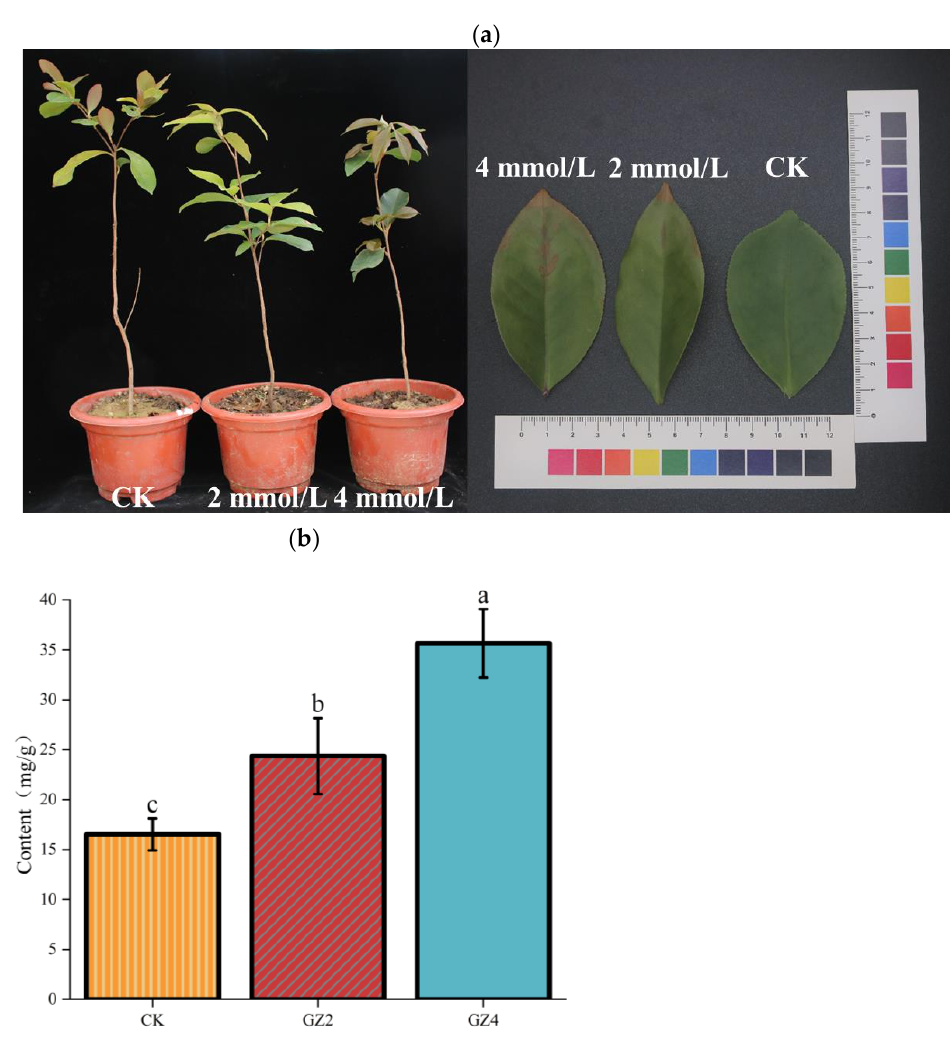
Figure 1. Responses of C. drupifera to aluminum treatment. ( a ) Morphological characteristics and ( b ) total flavonoid content under different concentrations of aluminum. In the histogram, different letters indicate statistical significance ( p < 0.05).